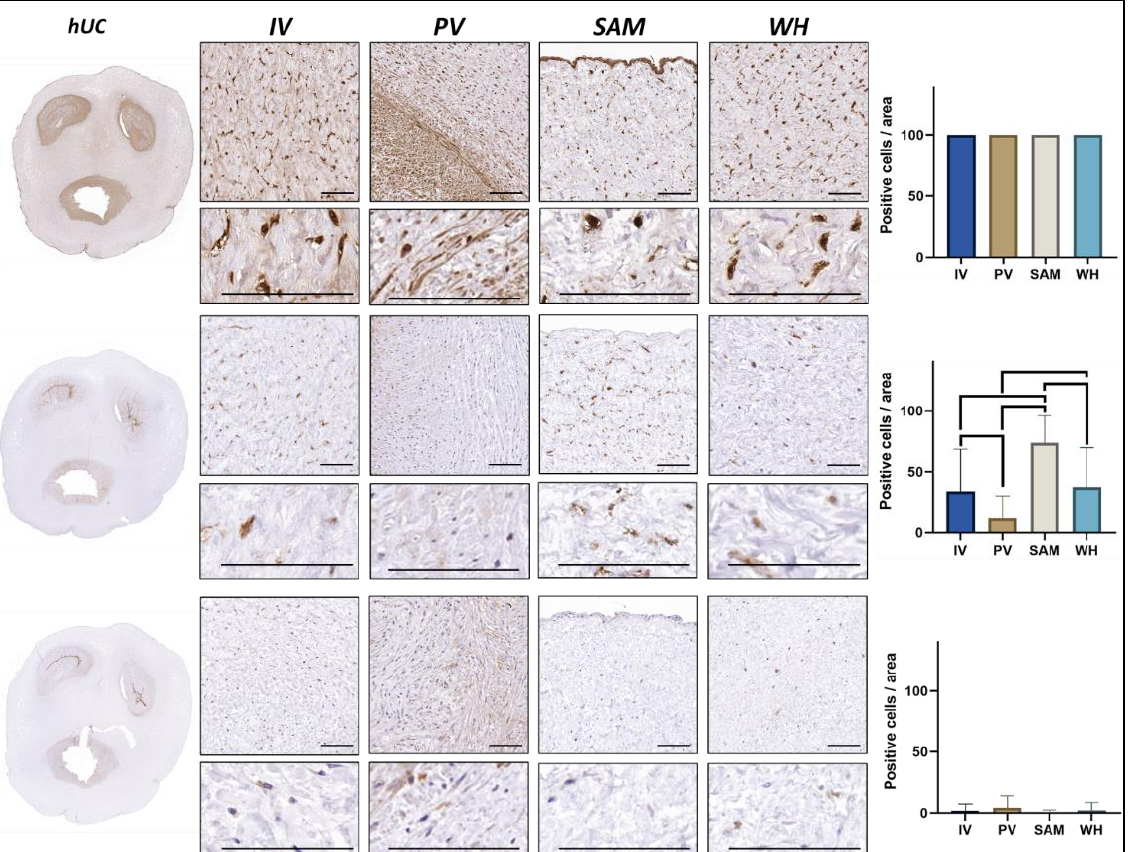
Figure 2. In situ immunohistochemical analysis of relevant MSC markers in cells found in the human umbilical cord (hUC) and its different zones. Images obtained at two different magnifications are shown for each marker. Quantification of the percentage of positive cells found in each sample and each method is shown in the histograms to the right, with statistically significant differences shown as brackets. IV: intervascular zone; PV: perivascular zone; SAM: subamnioblastic zone; WH: Wharton zone. Scale bar = 200 µm.